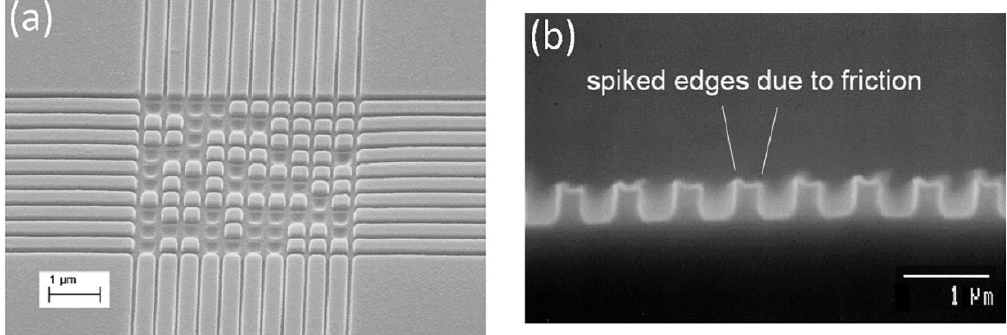
Figure 10. Polymer pattern defects after NIL. ( a ) Polymer pattern missing due to polymer sticking on mold; ( b ) spiked edges in polymer pattern due to friction forces.